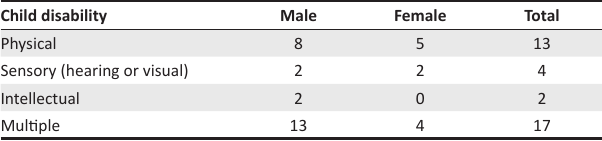
TABLE 1: Sample of children ( n =